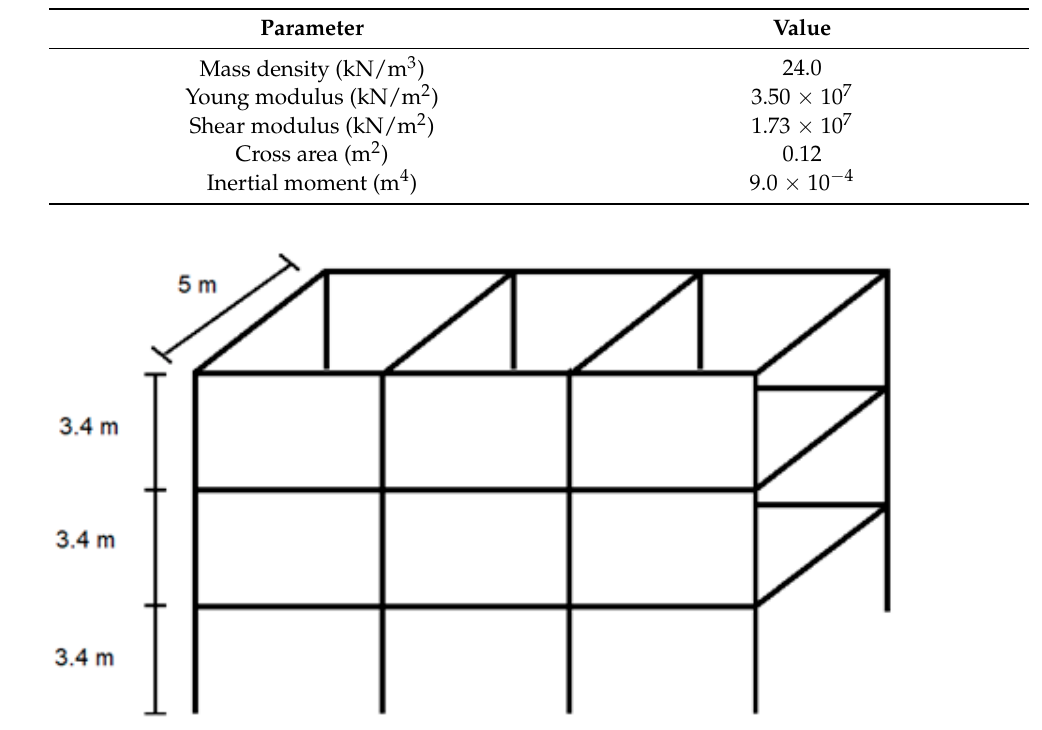
Table 3. Characteristics of the building.